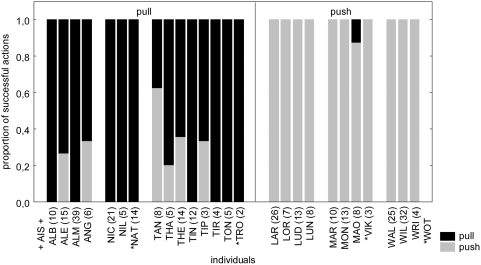
Second test block (tests 4–6).Proportion of successful actions push (grey bars) and pull (black bars) in constrained groups. Pull groups are shown on the left side, push groups on the right side. Digits in brackets indicate number of successes. Asterisks mark animals that performed first successful manipulations during test sessions. “AIS” disappeared before the second test block.